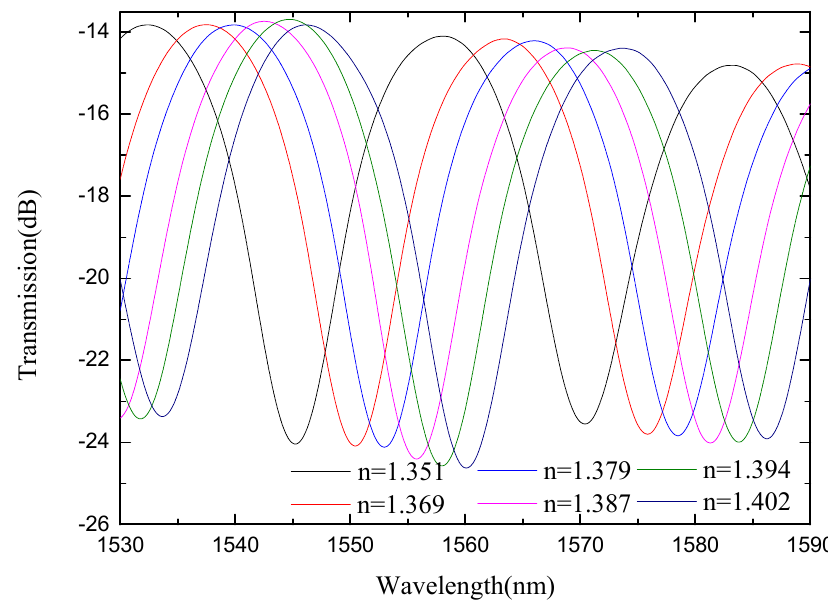
Figure 17. Spectra of ESMBMS MZI(1/2L) at different refractive indices.